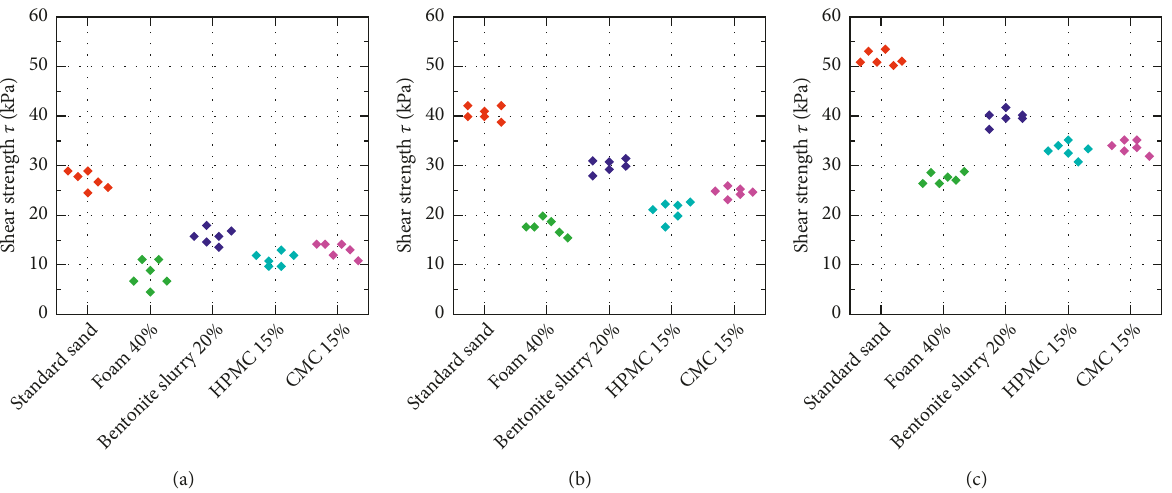
Figure 12: Comparison of shear strength τ for several conditioned sands at a shear rate v of 65.98mm/s: (a) 0.5bar; (b) 1 bar; (c)